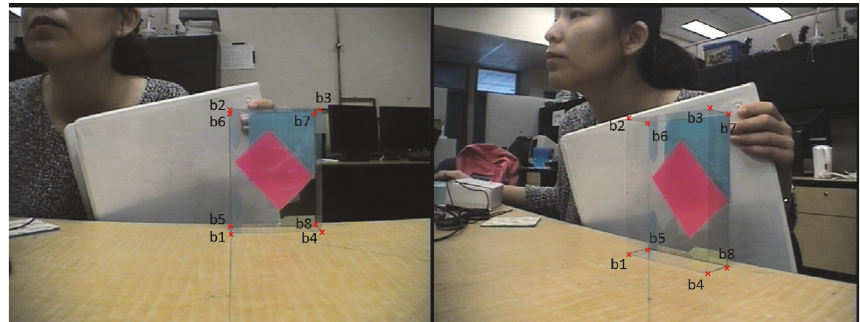
Figure 4: The transparent box in the view of two cameras. The eight corners are marked with red crosses.